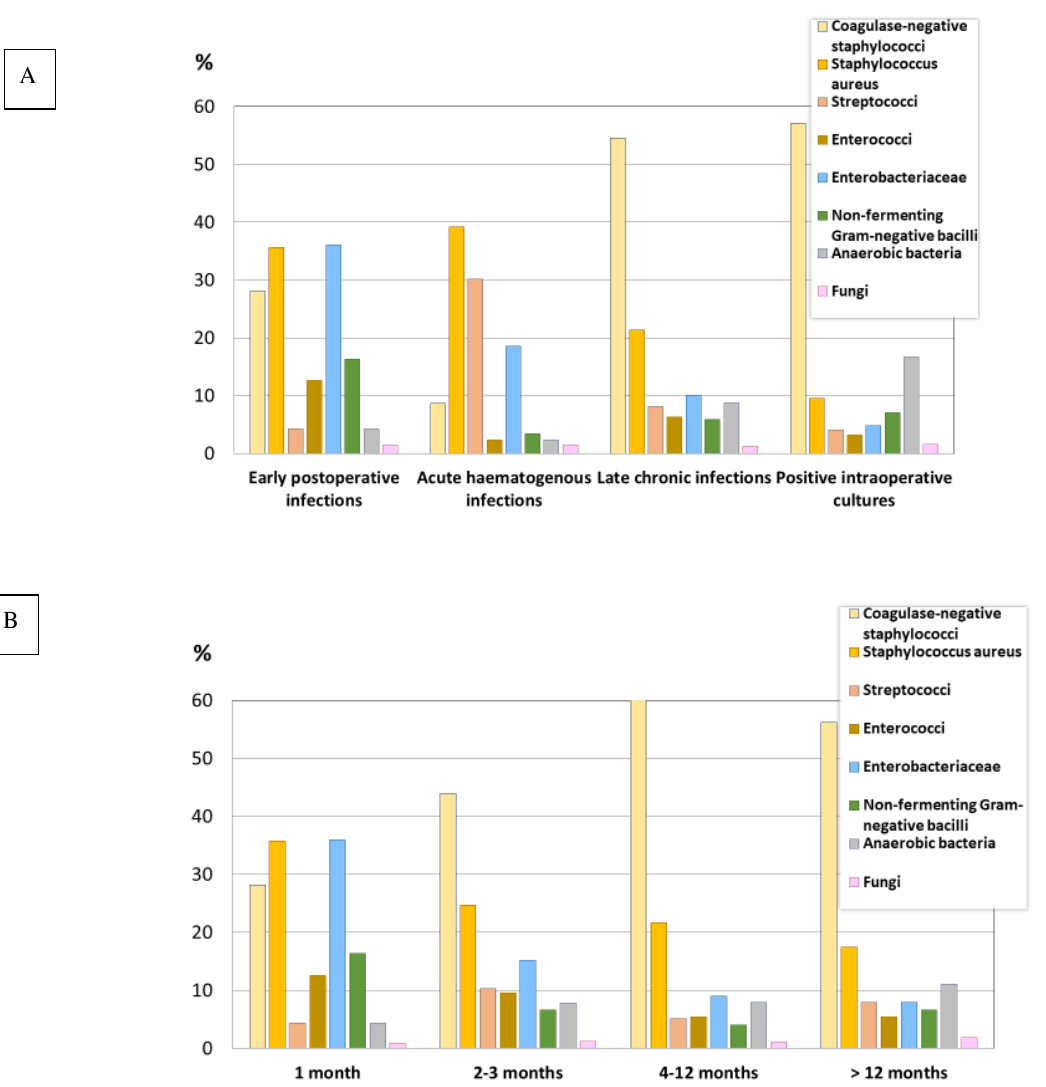
Figure 1. Main microorganisms or group of microorganisms involved in prosthetic joint infections according to Tsukayama’s classification ( A ), and in non-hematogenous prosthetic joint infection according to time since index surgery ( B ).